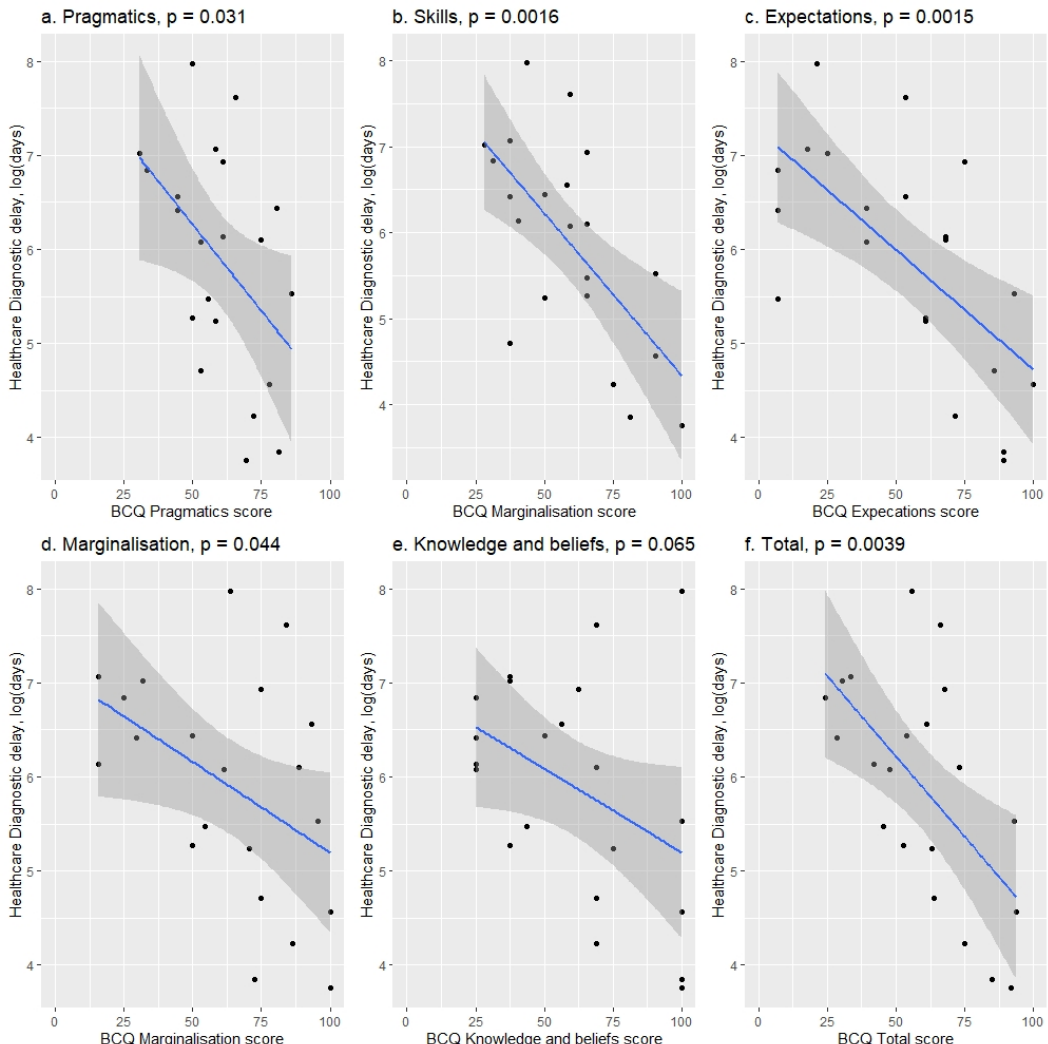
Figure 3. BCQ subscales relation to total healthcare delay. Higher scores on each individual subscale in the BCQ questionnaire correspond to lower healthcare delay. Median (IQR) for each subscale: prag- matics, 61 (51–72); skills, 59 (44–70); expectations, 61 (38–73); marginalisation, 66 (48–85); knowledge and beliefs, 63